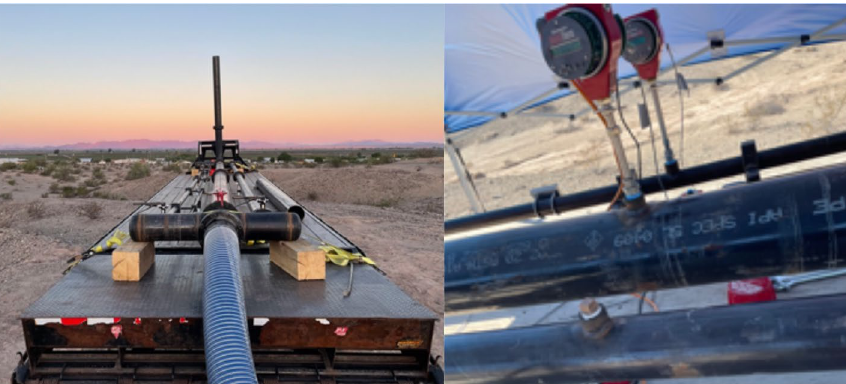
Figure 5. Metering and release trailer (left) has four pipes (0.5-in., 2-in., 4-in., and 8-in.), each leading to a distinct metering location allowing a different dynamic range of release volumes. The three larger pipes used a QuadraTherm 640i insertion meter (right), with upstream 8.5 m straight run of pipe to ensure sufficient flow stabilization for all pipes. The 0.5-in. pipe was not used in this study.